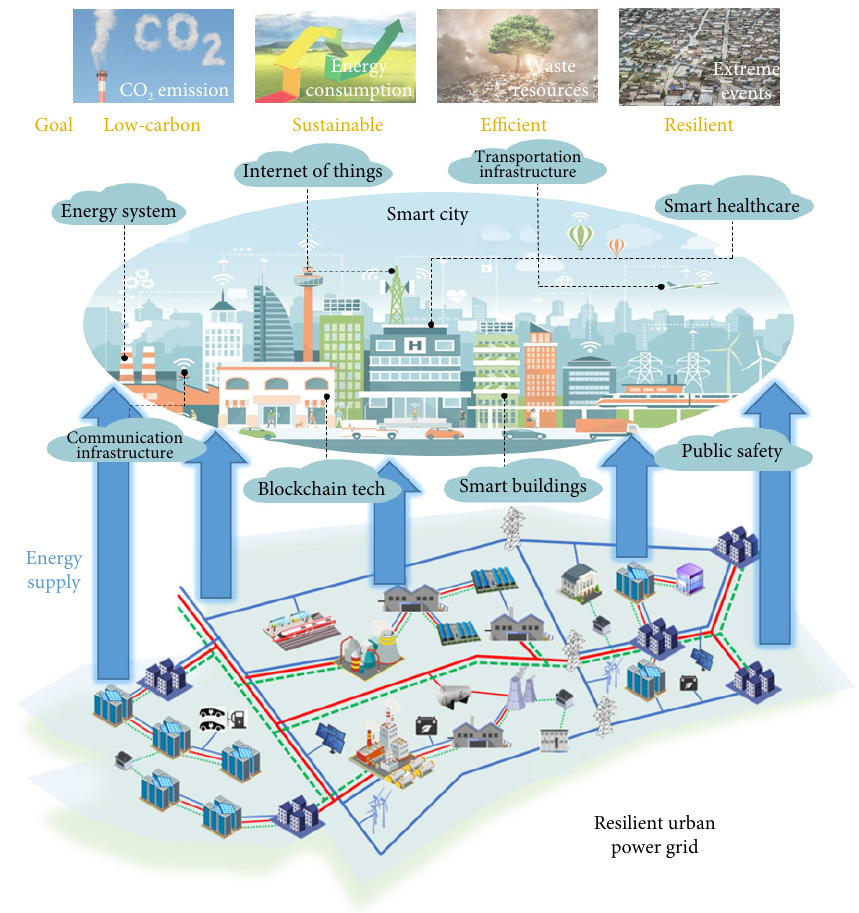
Fig. 1 An ideal smart city supported by a resilient power grid.